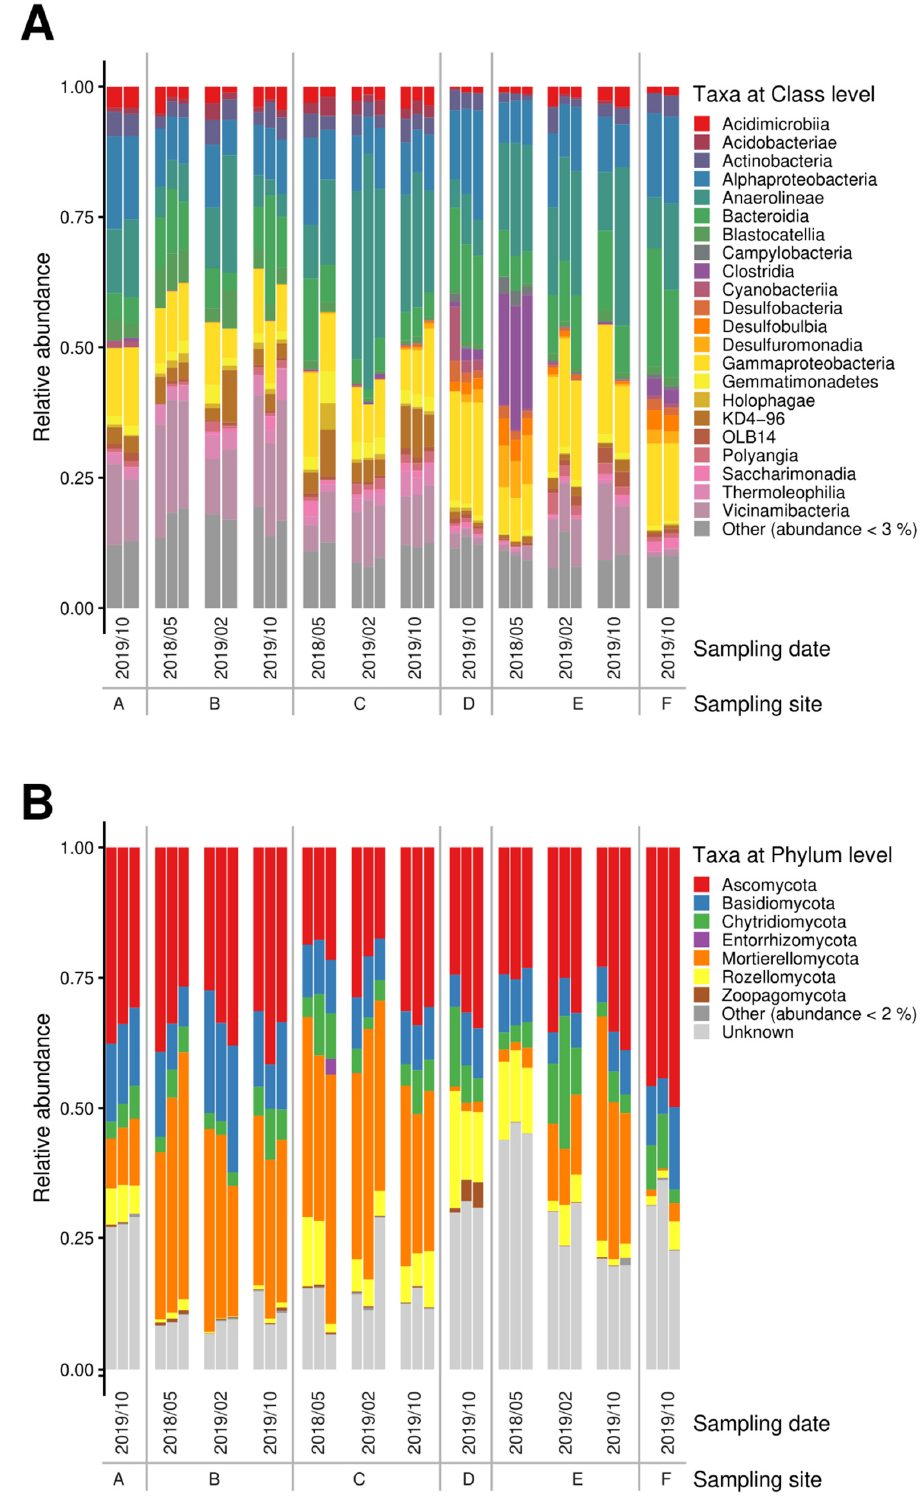
Figure 1. Bacterial ( A ) and fungal ( B ) microbiomes along a contamination gradient from sites A to E (compare Supplementary Figure S1).